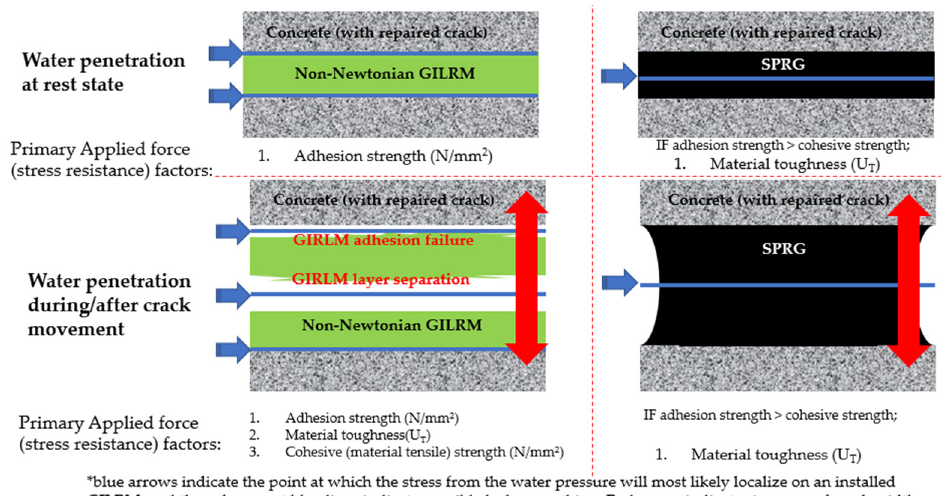
Figure 2. Failure types and mechanism of GILRM illustrated.